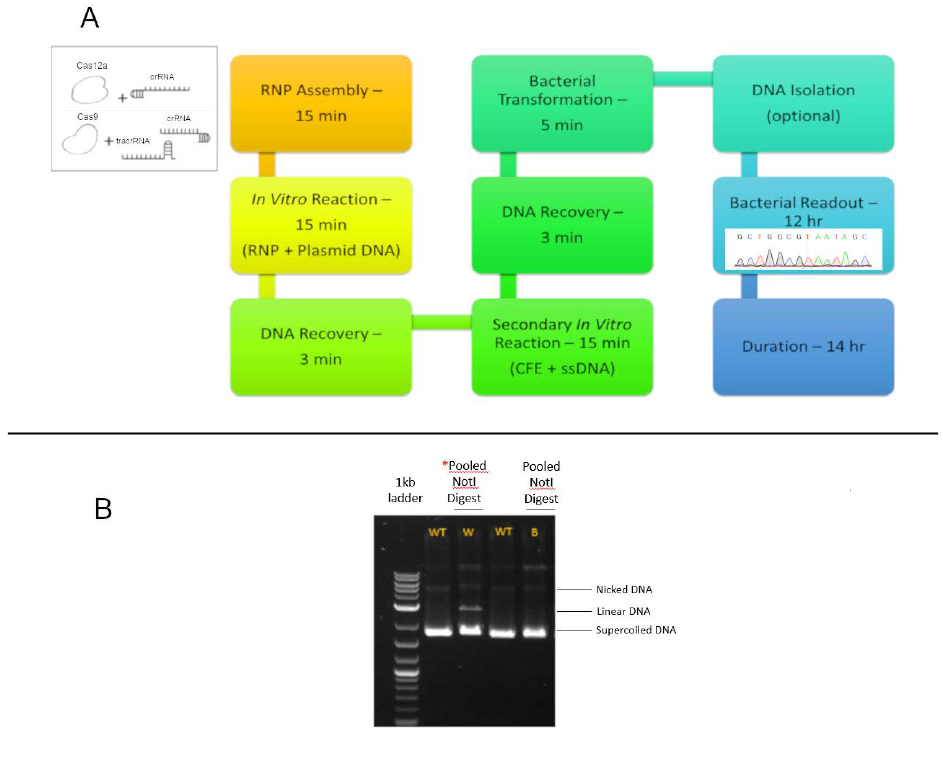
Figure 2. In vitro gene editing workflow and NOTI digestion assay. ( A ) In vitro workflow. The workflow starts with the complexation of CRISPR / Cas12 and / or CRISPR / Cas9 with the appropriate crRNA / tracrRNA + crRNA’s to form a ribonucleoprotein (RNP). After formation, the RNP is added to a reaction containing plasmid DNA, incubated for 15 min, and then cleaved DNA is recovered. The DNA is added to a second reaction with cell-free extract, ssDNA oligonucleotide, and undergoes DNA recovery once more. The recovered DNA is transformed into Escherichia coli bacteria, incubated overnight, and bacterial readout is observed after 12 h. ( B ) Pooled NOTI digestion assay. A NOTI digestion agarose gel is shown with five columns; the first column illustrates the 1 kb ladder and the remaining four columns show pooled white and blue colony samples along with a control, uncut LacZ plasmid. A linear band can be seen in the pooled white colony samples indicating several colonies with an intact NOTI site. The red asterisk signifies that only the white colony pool demonstrated NOTI cleavage. The pooled blue sample shows only wildtype (WT) uncut, plasmid